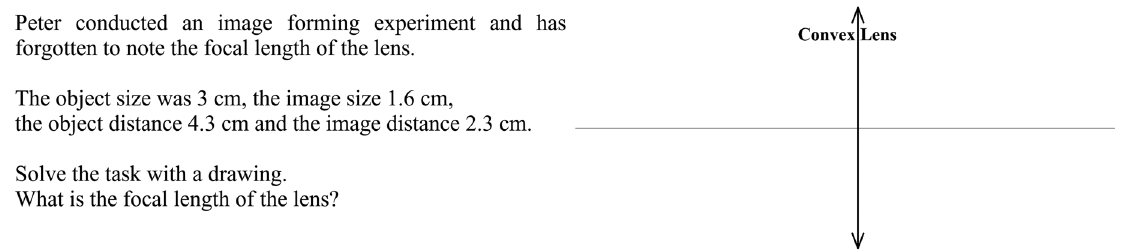
FIG. 6. Example of a standard item for assessment of RCA (item 7 [145,146]): building a ray diagram with given values.